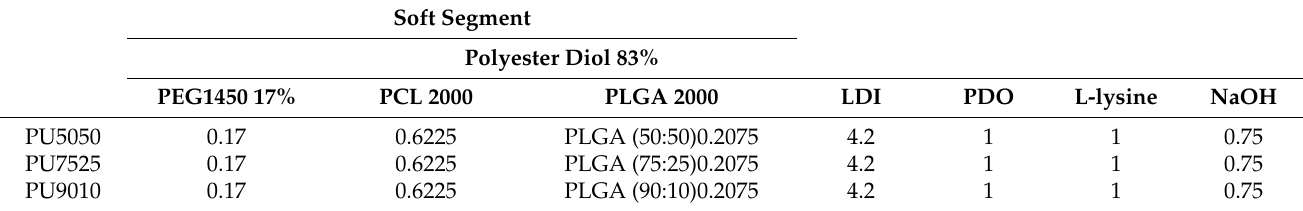
Table 1. The molar composition of WPUs (R value (-NCO/(-OH+-NH 2 )) is 1.4). Soft